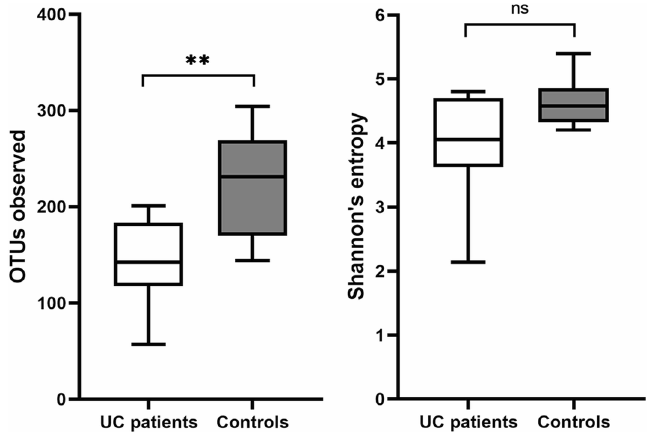
Figure 1. Microbial alpha diversity as OTU-richness and Shannon’s entropy in UC patients and healthy controls. p -value calculated using the non-parametric Mann–Whitney test, ** p < 0.01, ns—no significance.